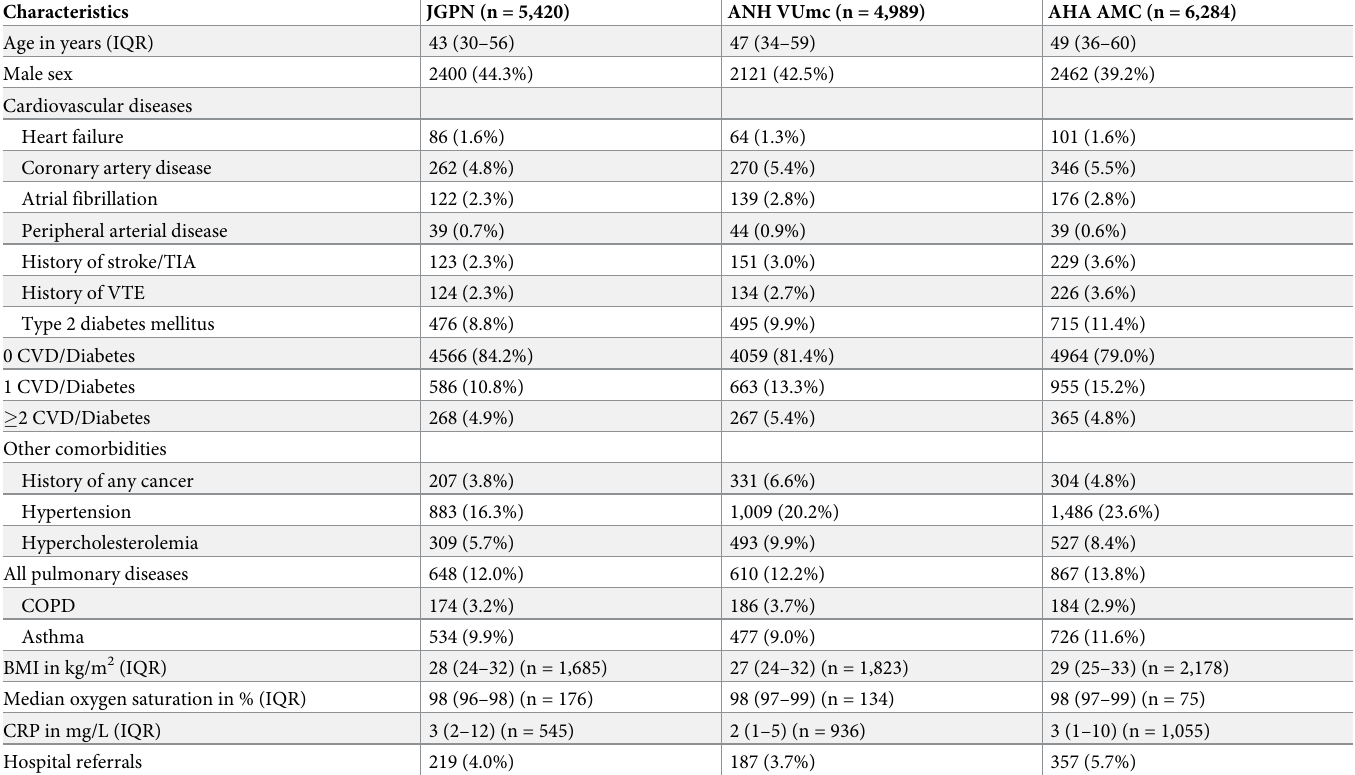
Table 2. Baseline characteristics of the validation cohort of 16,693 community patients with confirmed COVID-19.